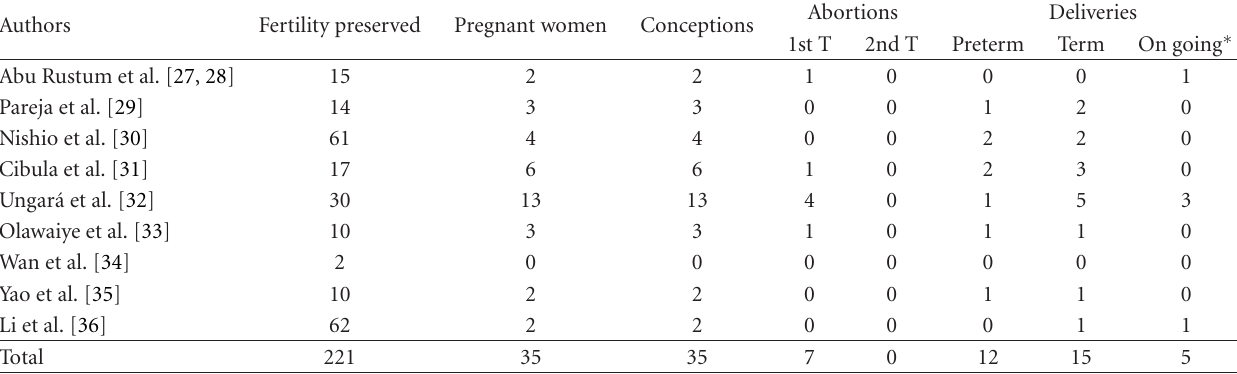
Table 5: Pregnancy outcomes of ART.